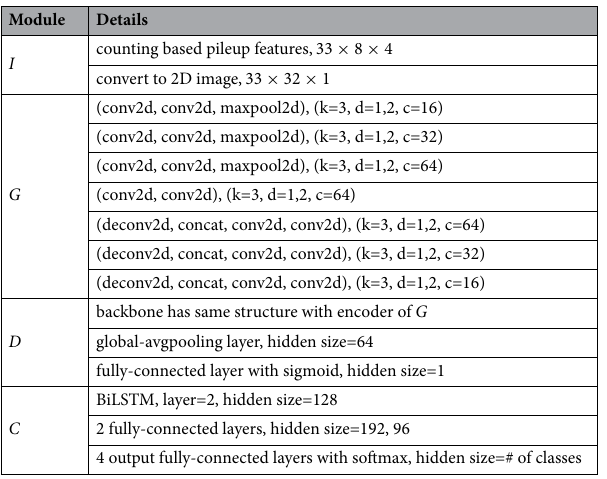
Table 4. The detailed layers in our LDV-Caller. k, d, c respectively represent kernel size, dilation radius, channel